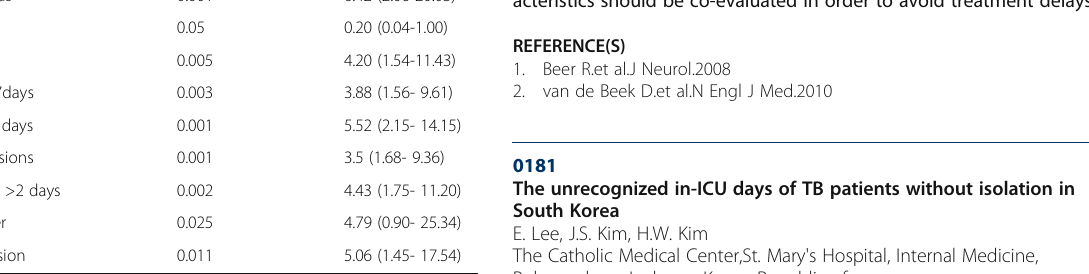
Table 2 (abstract 0179). REGRESSION MODEL FOR RISK FACTORS FOR MORTALITY WITH INFECTION Parameter P value Odd Ratio (95% CI) Diabetes